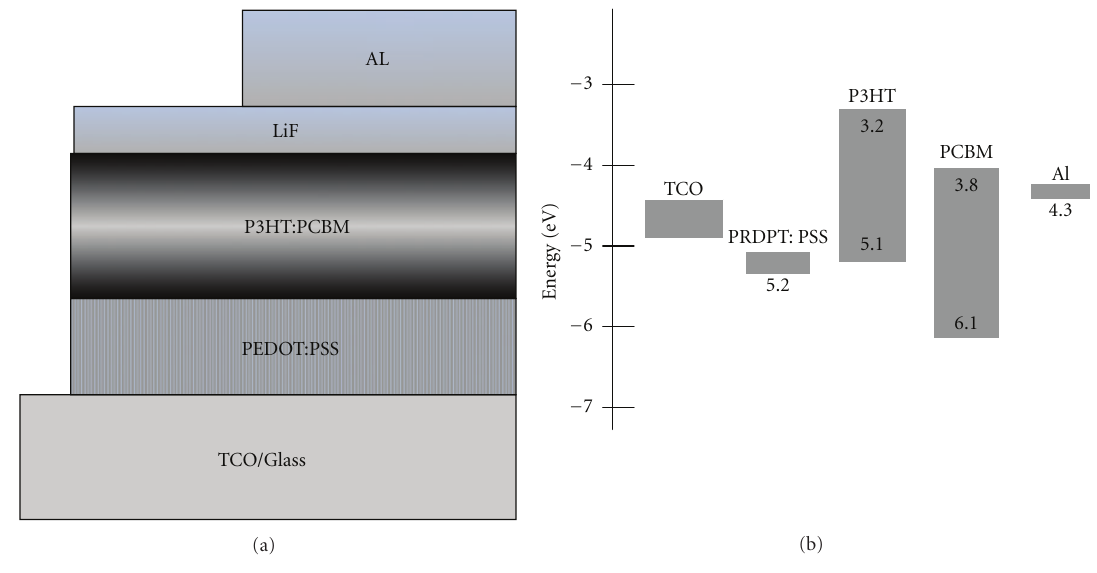
Figure 1: (a) Device structure and (b) energy diagram of OPVs.